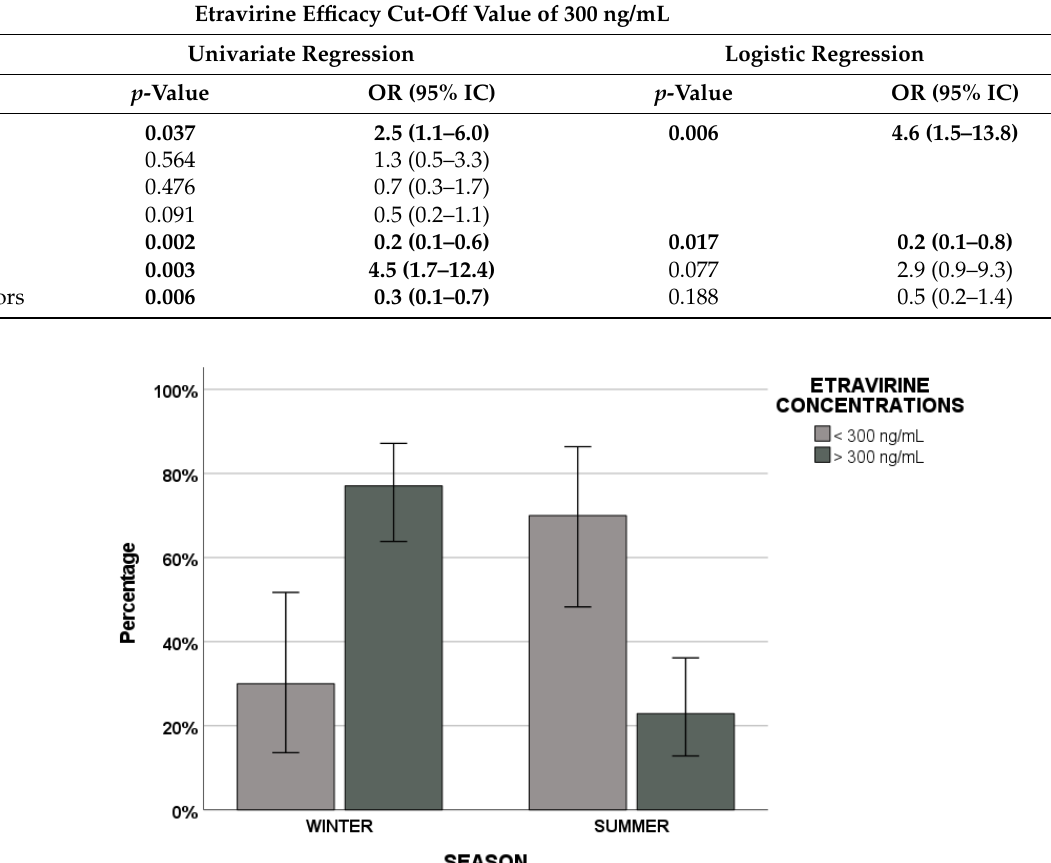
Table 3. Logistic regression analysis for predictors of etravirine effectiveness cut-off value. In bold, statistically significant values.